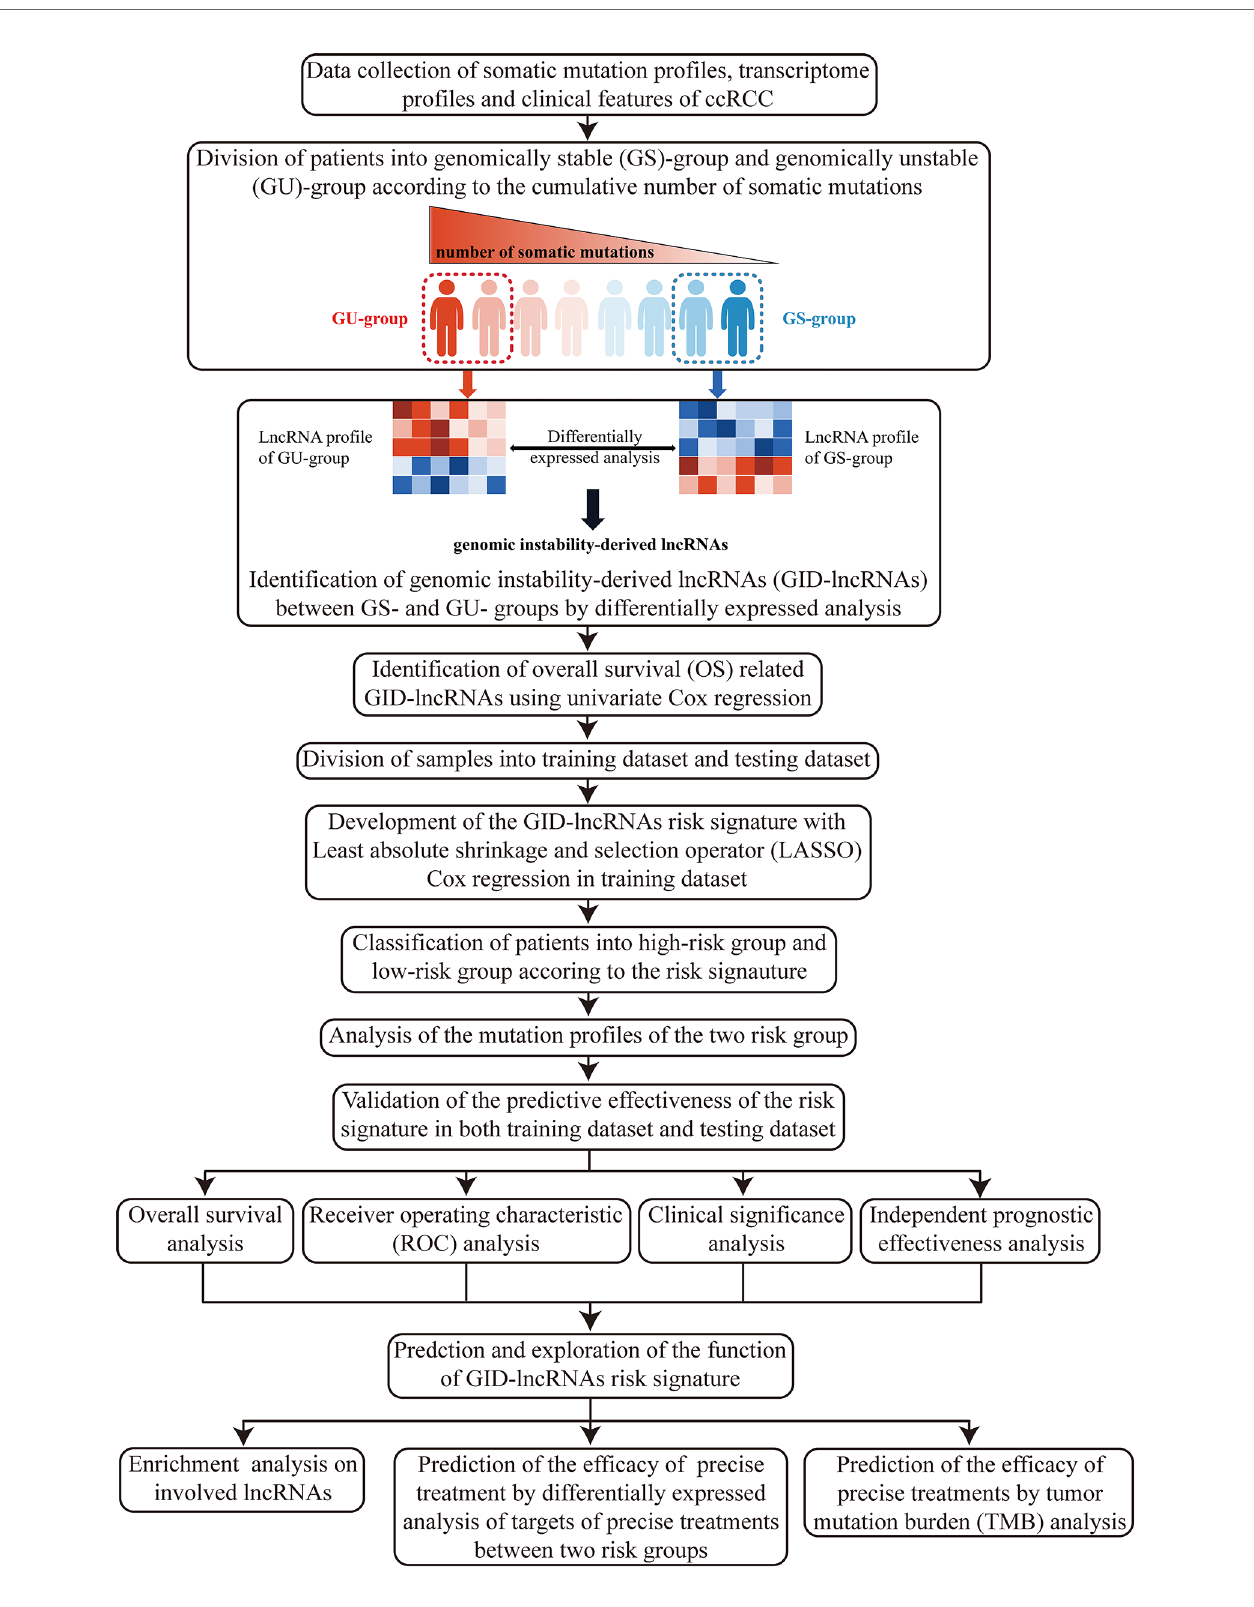
FIGURE 1 | Flow chart of the design and overall procedures of our